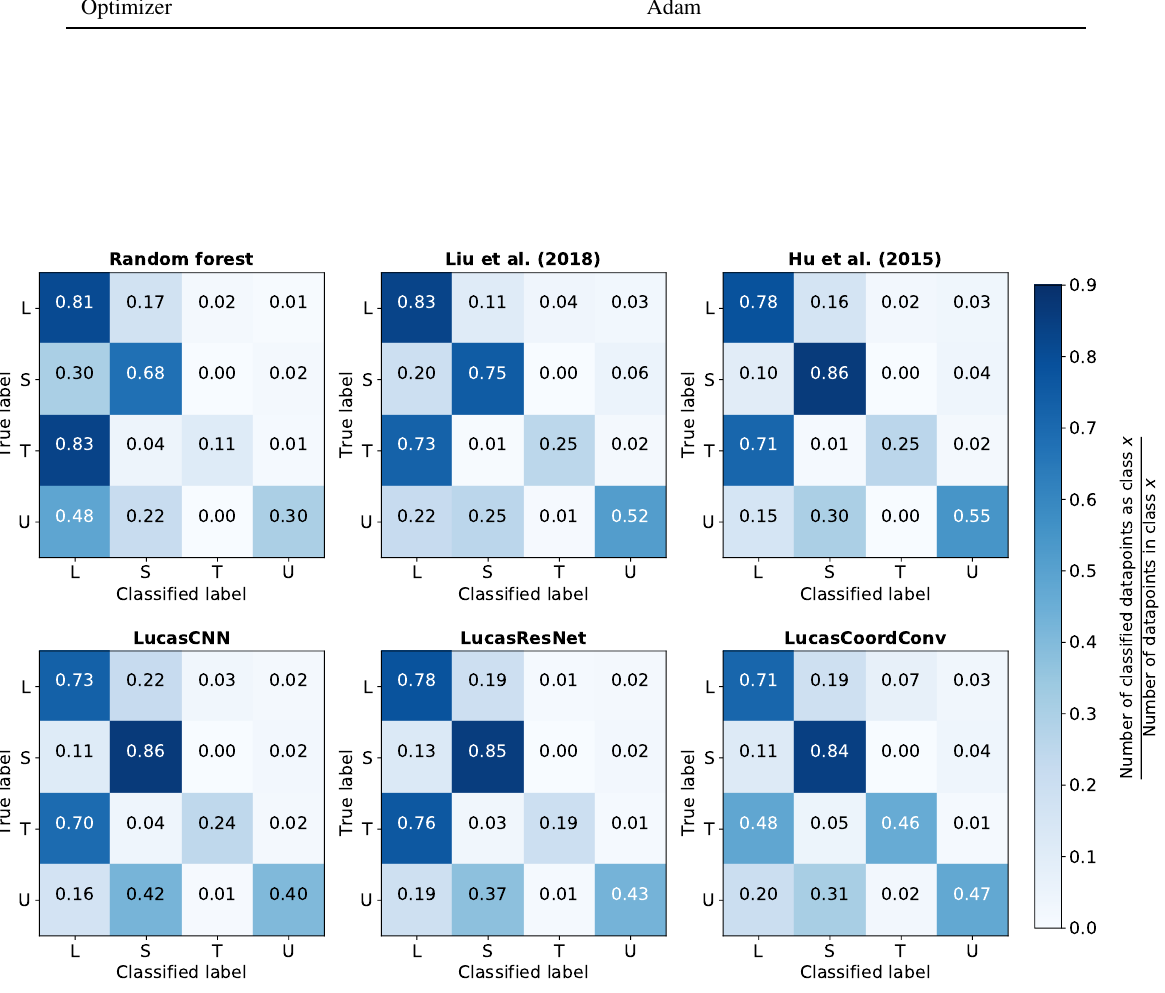
Figure 5. Normalized confusion matrices based on the test